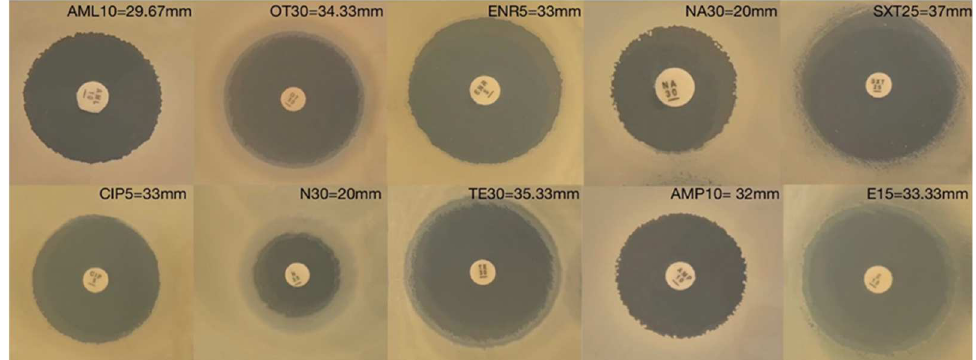
Figure 5. Antibiotic susceptibility of Bacillus isolate B29 to commercial antibiotics, including ampi- cillin (AMP10), neomycin (N30), oxytetracycline (OT30), ciprofloxacin (CIP5), enrofloxacin (ENR5), erythromycin (E15), sulphamethoxazole (SXT25), tetracyclin (TE30), amoxycillin (AML10), and nalidixic acid (NA30).